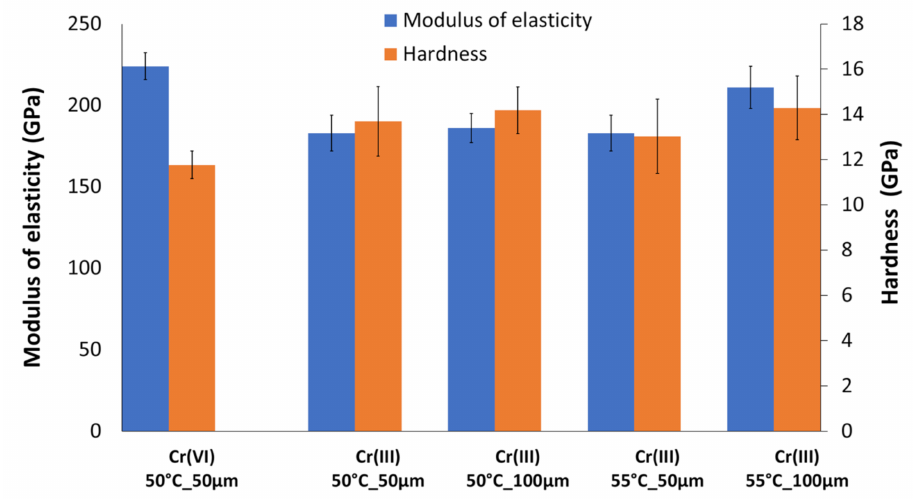
Figure 5. Hardness and rigidity of trivalent chromium deposits as a function of thickness and electrolyte temperature.